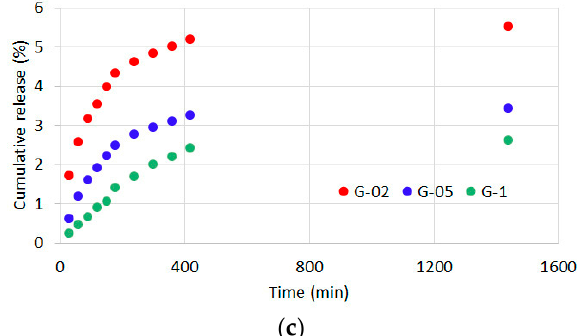
Figure 6. Curcumin cumulative release, expressed as a percentage of the initial content, from G films incubated in ( a ) H 2 O/EtOH solution (1:1); ( b ) physiological solution and ( c ) PBS.